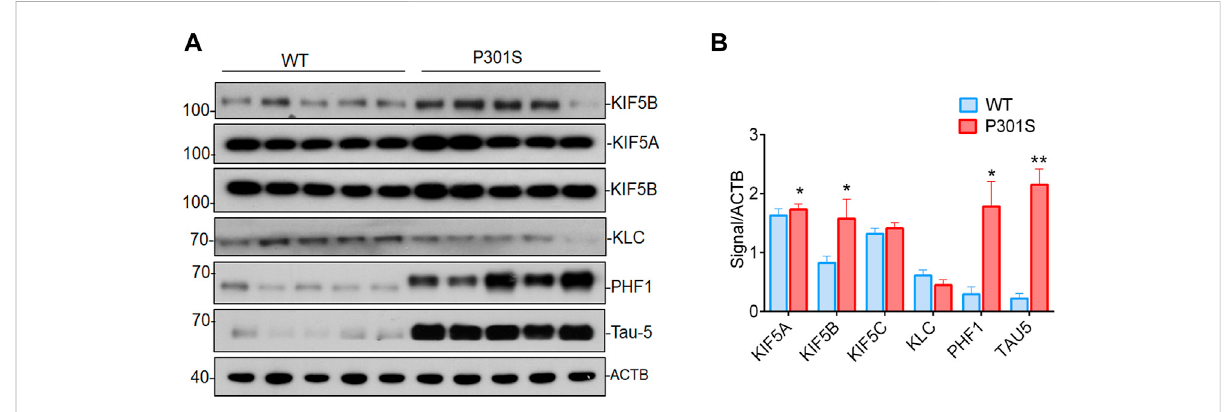
FIGURE 1 Accumulation of KIF5B, phospho tau and total tau proteins in P301S mice). (A) Western blotting was performed to detect the expression of KIF5B, KLC, phospho tau PHF1 and total tau 5 (Tau-5) in the brain lysates of 4-month-old WT and P301S mice; (B) Quantitative analysis of immunoblot showed that KIF5B, PHF1 and Tau-5 but not KLC levels are signi fi cantly increased in P310S mice ( n = 5). The bar diagram represents the means of 3 independent experiments; the error bars represent the SEM (mean ± SEM) of 3 independent experiments, * p < 0.05, and ** p < 0.01 (WT vs.